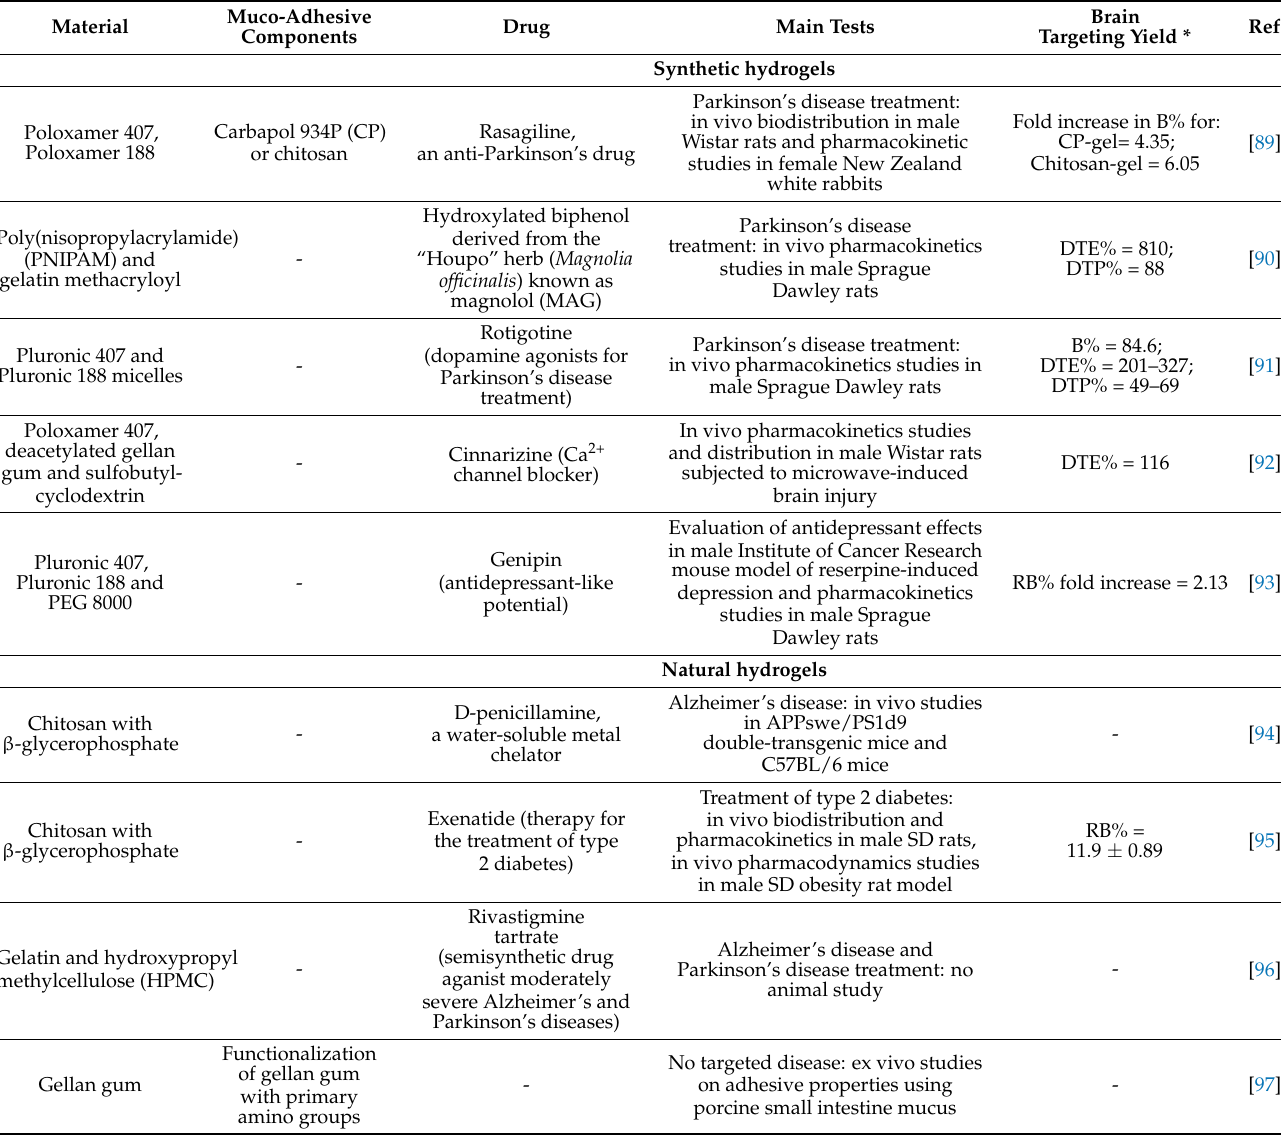
Table 3. Main hydrogels exploited in IN drug delivery to treat brain